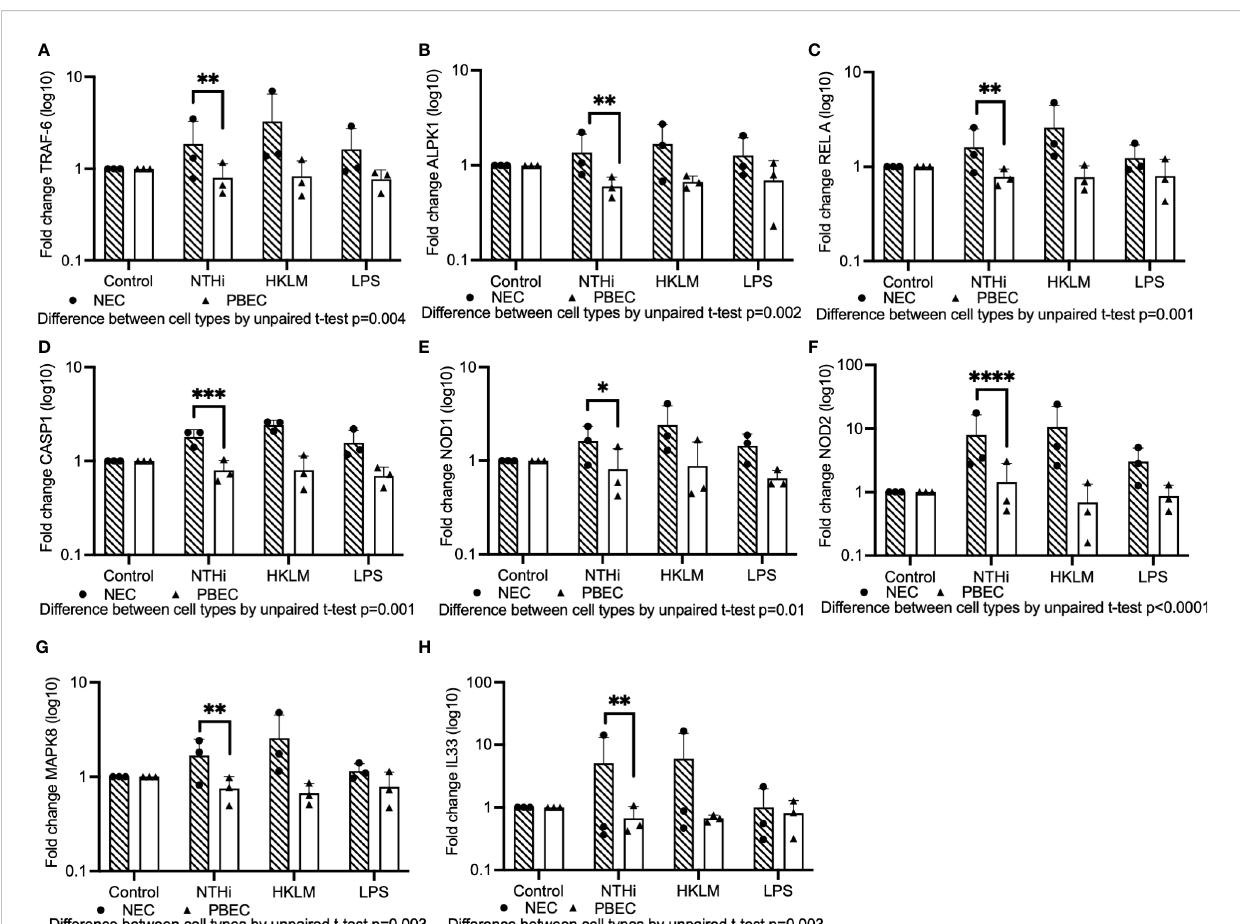
FIGURE 4 A Fluidigm Biomark PCR array experiment was performed to evaluate gene expression induced by NTHi in PBECs compared with NECs cultured at ALI. Mature ALI cultures were inoculated with a selection of NTHi strains, HKLM or LPS, and incubated in the presence of extracellular bacteria for 24 hours prior to isolation of RNA. (A) TLR-signaling pathway component TRAF6 was expressed at higher levels in NECs compared to PBECs inoculated with NTHi. (B) ALPK1 is more highly induced in NECs compared to PBECs. (C) Expression of NF-kB component RelA was signi fi cantly higher in